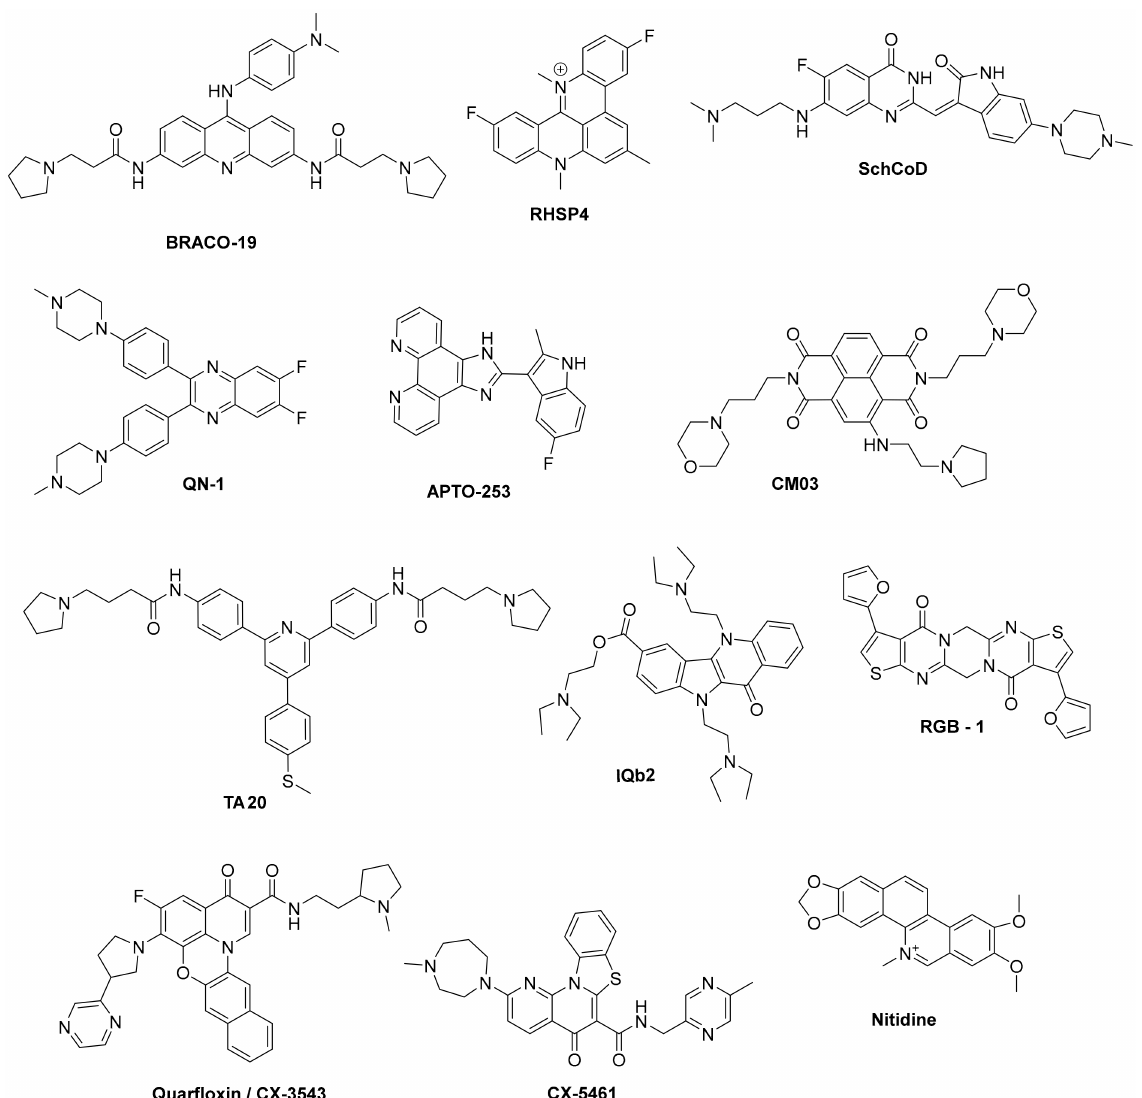
Figure 4. Structures of G4 ligands with anticancer activity. G4s can also be formed in different sites of mRNA strand, affecting not only translation but also mRNA splicing and translocation (Figure 3C). G4s at 5 (cid:48) UTR region can interfere with recruitment or scanning of 43S pre-initiation complex and consequently inhibit transla- tion, whereas G4s at open reading frames can also repress translation by stalling ribosomes; G4s within introns can lead to alternative splicing; and G4s at 3 (cid:48) UTR can interfere with mRNA maturation, translocation and translation [20,96]. Examples of small molecules targeting RNA G4s are fewer. One such example is that of RGB-1 (Figure 4), an RNA G4 selective ligand found through a reverse transcriptase-based screening method using the telomeric repeat-containing RNA (TERRA) G4-forming sequence. This molecule was shown to decrease translation of mRNA containing G4 structures, both in-vitro and in cancer cells